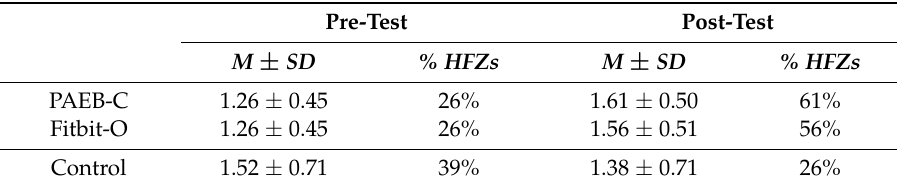
Table 3. Average aerobic fitness scores and percentage of healthy fitness zones (HFZs) at the pre- and post-test by